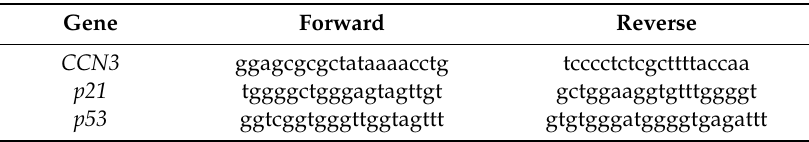
Table 3. Primer sequences for